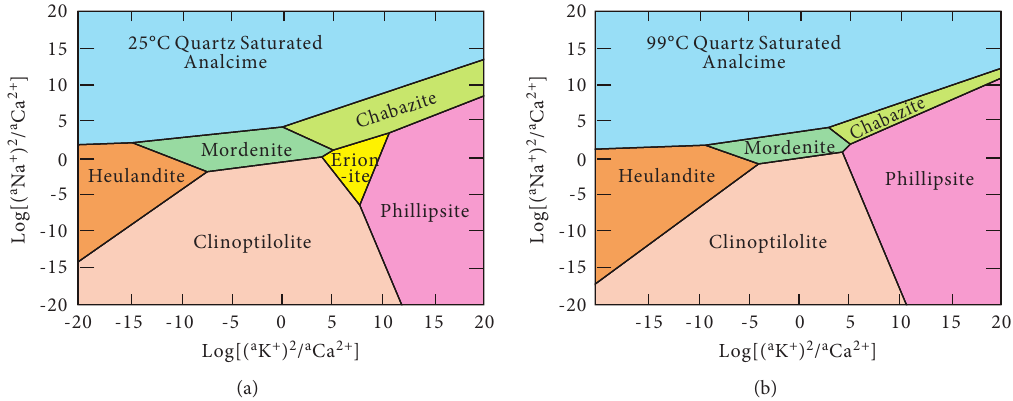
Figure 4: The difference in log[( a K + ) 2 / a Ca 2+ ] versus log[( a Na + ) 2 / a Ca 2+ ] of zeolite phases under quartz saturation at different temperatures (modified according to Chipera et al., 2008) [45]. (a) The difference of log[( a K + ) 2 / a Ca 2+ ] versus log[( a Na + ) 2 / a Ca 2+ ] of zeolite phases under quartz saturation at 25 ° C. (b) The difference of log[( a K + ) 2 / a Ca 2+ ] versus log[( a Na + ) 2 / a Ca 2+ ] of zeolite phases under quartz saturation at 99 °